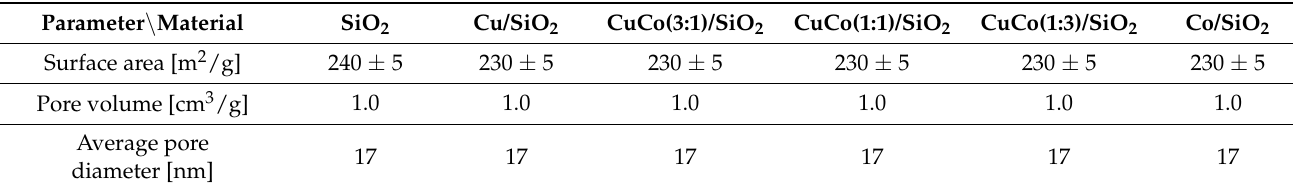
Table 1. Cu/SiO 2 , CuCo/SiO 2 and Co/SiO 2 physicochemical